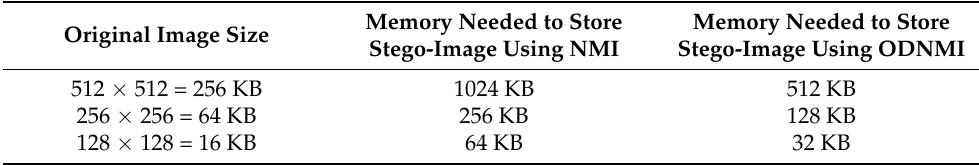
Table 4. Memory usage of the NMI and proposed ODNMI schemes. Original Image